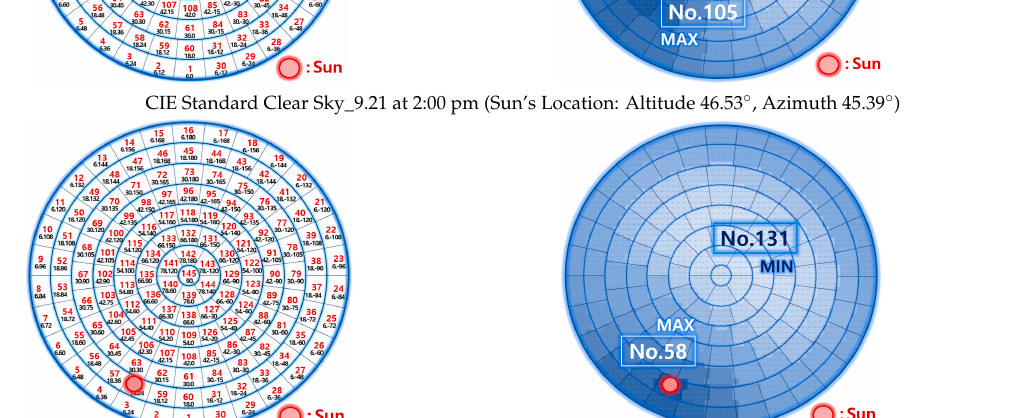
Table 8. Cont. Table 8. Table 8. Cont.